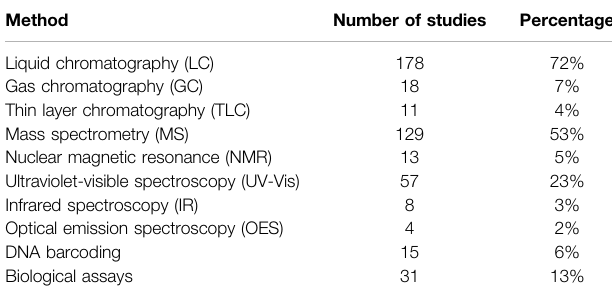
TABLE 1 | Occurrence of methods used in quality control of herbal